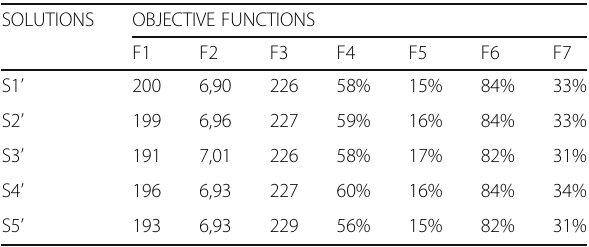
Table 3 Sample of Pareto optimal solutions proposed in